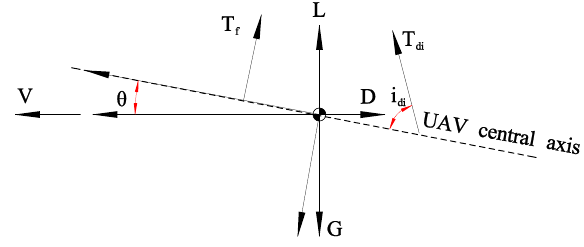
Figure 5. Schematic graph of force during transition flight.